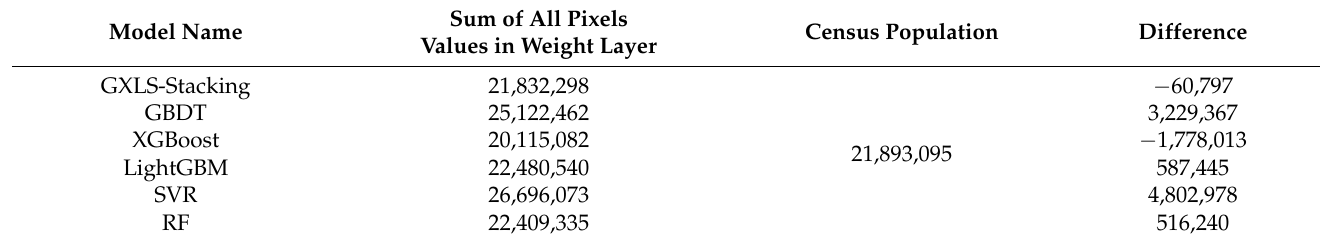
Table 4. The sum of all pixel values in the weight layers compared with census population.